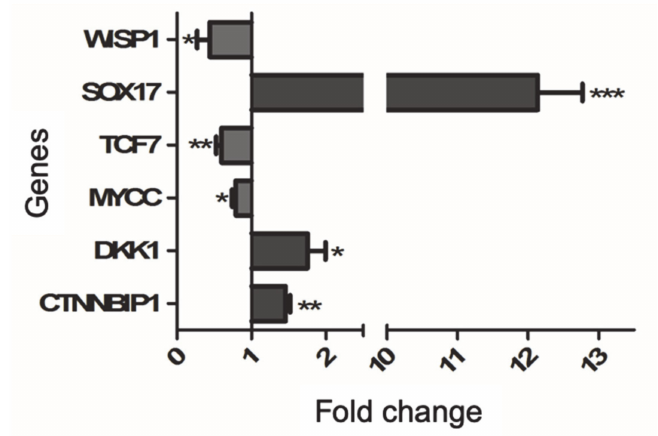
Figure 6. Validation of selected Wnt / β -catenin pathway by qRT-PCR in trabectedin-treated NCI-H295R cells. RNA was extracted and retro-transcribed as described in Materials and Methods. Genes were measured by q-RT-PCR using SYBR Green as fluorochrome. Results are presented as fold change ± SEM; * p < 0.01; ** p < 0.05; *** p <